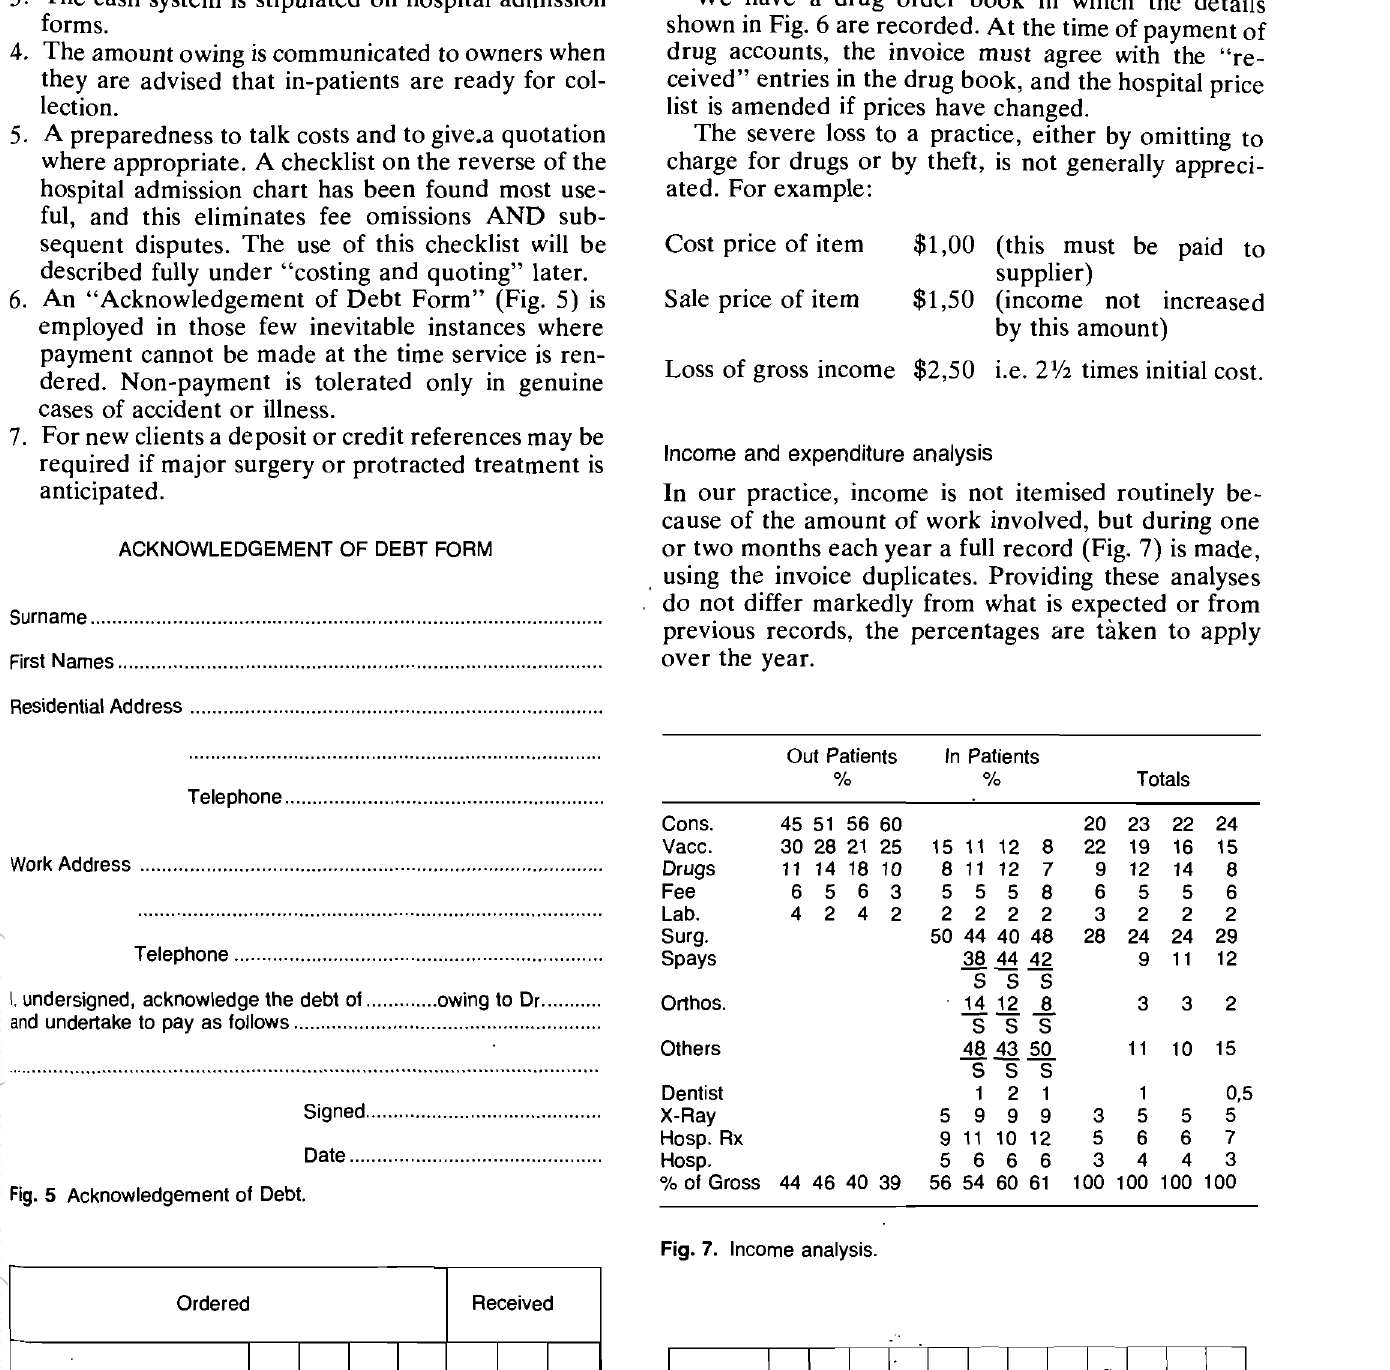
Fig. 7. Income analysis.